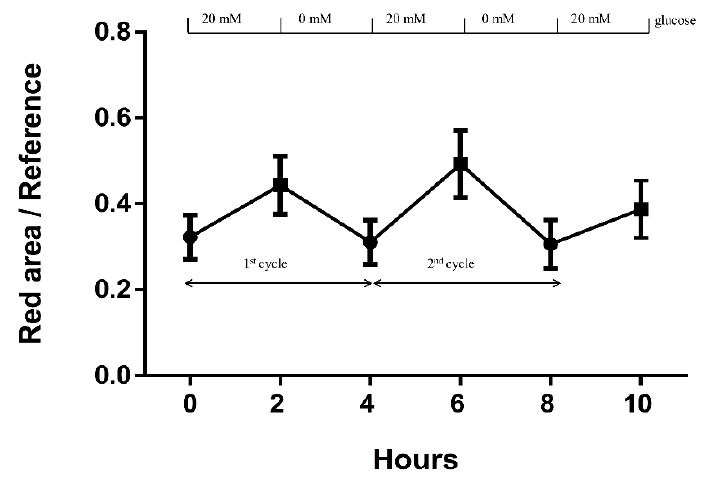
Figure 7. Continuous and reversible glucose sensing. PBA-based HEMA contact lens for continuous sensing in 0 and 20 mM glucose solvent. The trial was repeated three times.